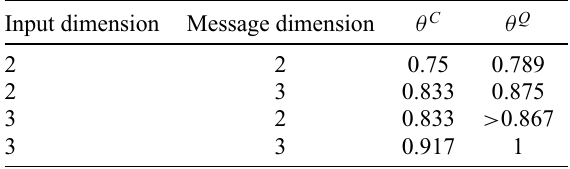
. Overall, 3 ( 8 + 8 + 4 9 9